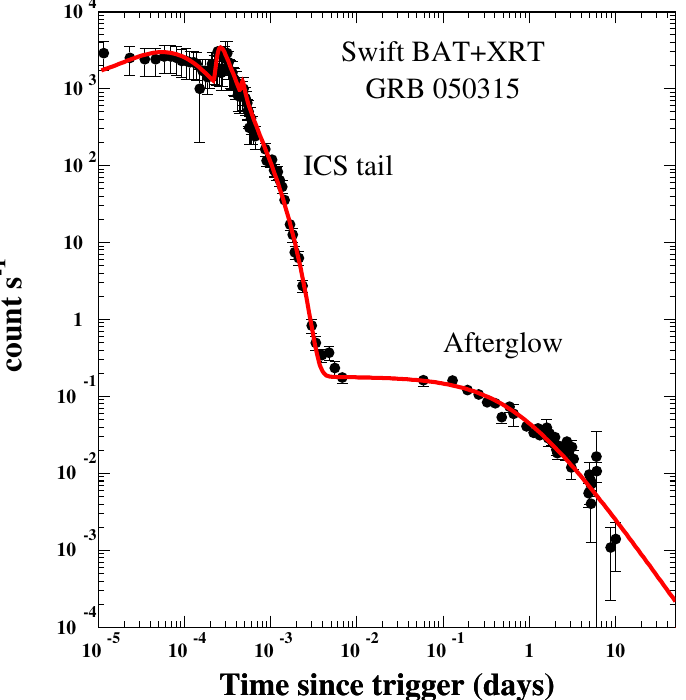
Figure 11. The X-ray afterglow of GRB050315 measured with the telescopes aboard Swift compared to its best fit canonical X-ray afterglow predicted by the CB model [57,91] for